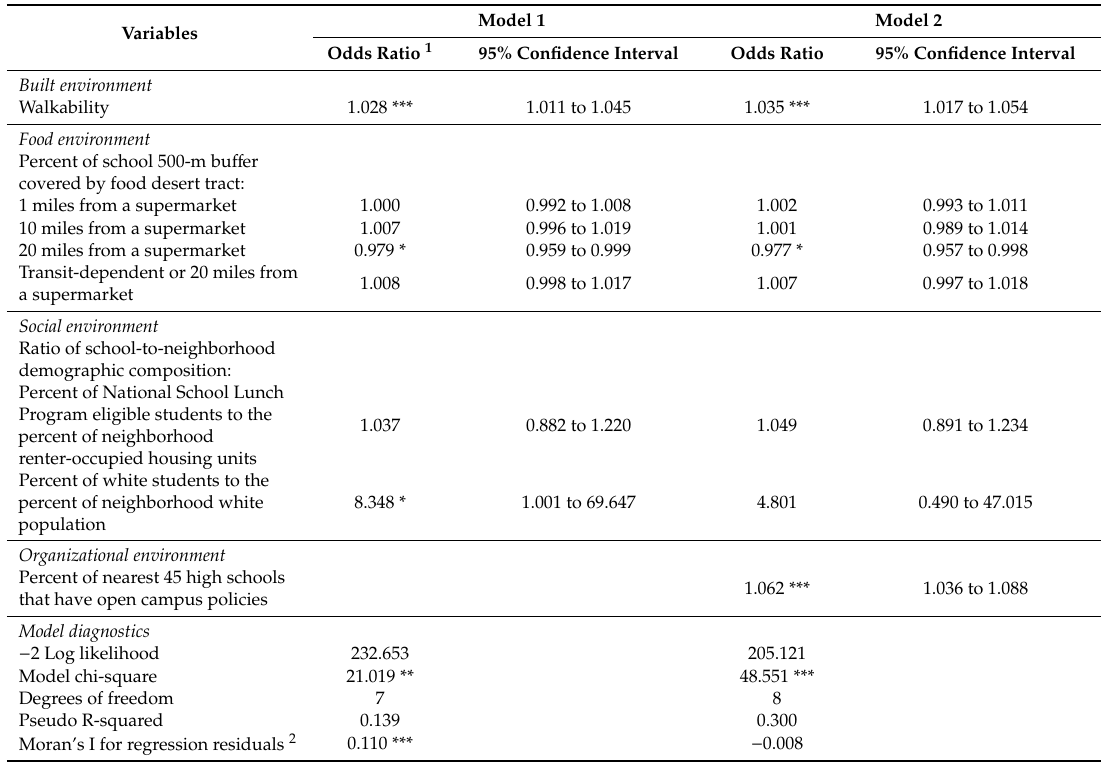
Table 3. Logistic regression results for open campus policy holding ( n = 200 public high